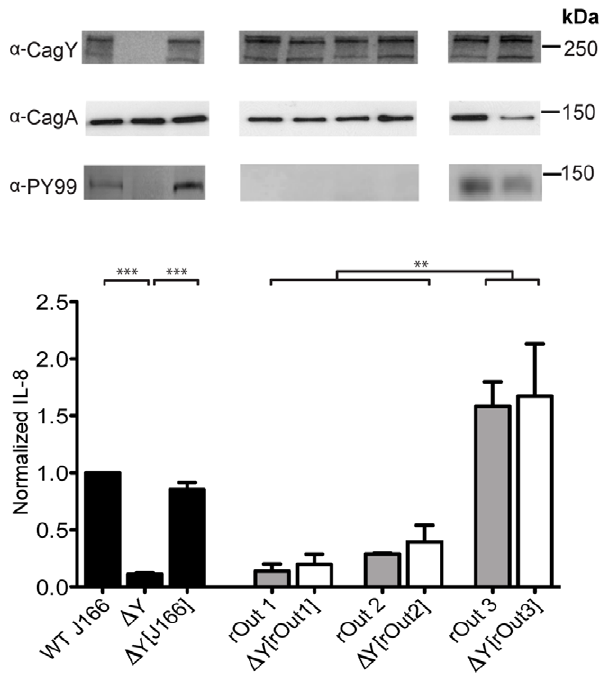
Figure 2. Recombination in cagY during infection of rhesus monkeys is sufficient to reduce the capacity of H. pylori to induce IL-8 and translocate CagA. Deletion of cagY ( n Y) from WT H. pylori J166 significantly reduced its capacity to induce IL-8 (mean 6 SEM of 3 replicates), which was recovered when the chromosomal WT cagY allele was restored ( n Y [J166]) by complementation (black bars). Immunoblot showed that only the WT or n Y [J166] expressed CagY protein ( a -CagY) and translocated CagA that was tyrosine phosphor- ylated ( a -PY99). Two rhesus output strains with unique cagY alleles (rOut1, rOut2) lost the capacity to induce IL-8 (gray bars) and translocate CagA, although they expressed CagY. Replacement of n cagY with cagY from rOut1 ( n Y [rOut1]) or rOut2 ( n Y [rOut2]) recapitulated their failure to induce IL-8 induction (white bars) and translocate phosphorylated CagA. Similarly, complementation with cagY from an output strain (rOut3) that expressed a unique cagY but maintained the capacity to induce IL-8 (gray bar) and translocate CagA, also phenocopied its IL-8 induction and translocation of CagA. All strains expressed CagA ( a -CagA), though only those that induced IL-8 had the capacity to translocate CagA that was tyrosine phosphorylated. Multiple bands in the CagY immunoblot could represent different transcription or translation products, or even protein fragments, but they are CagY-specific since they are absent in the cagY deletion mutant. ** P , 0.01; *** P , 0.001.